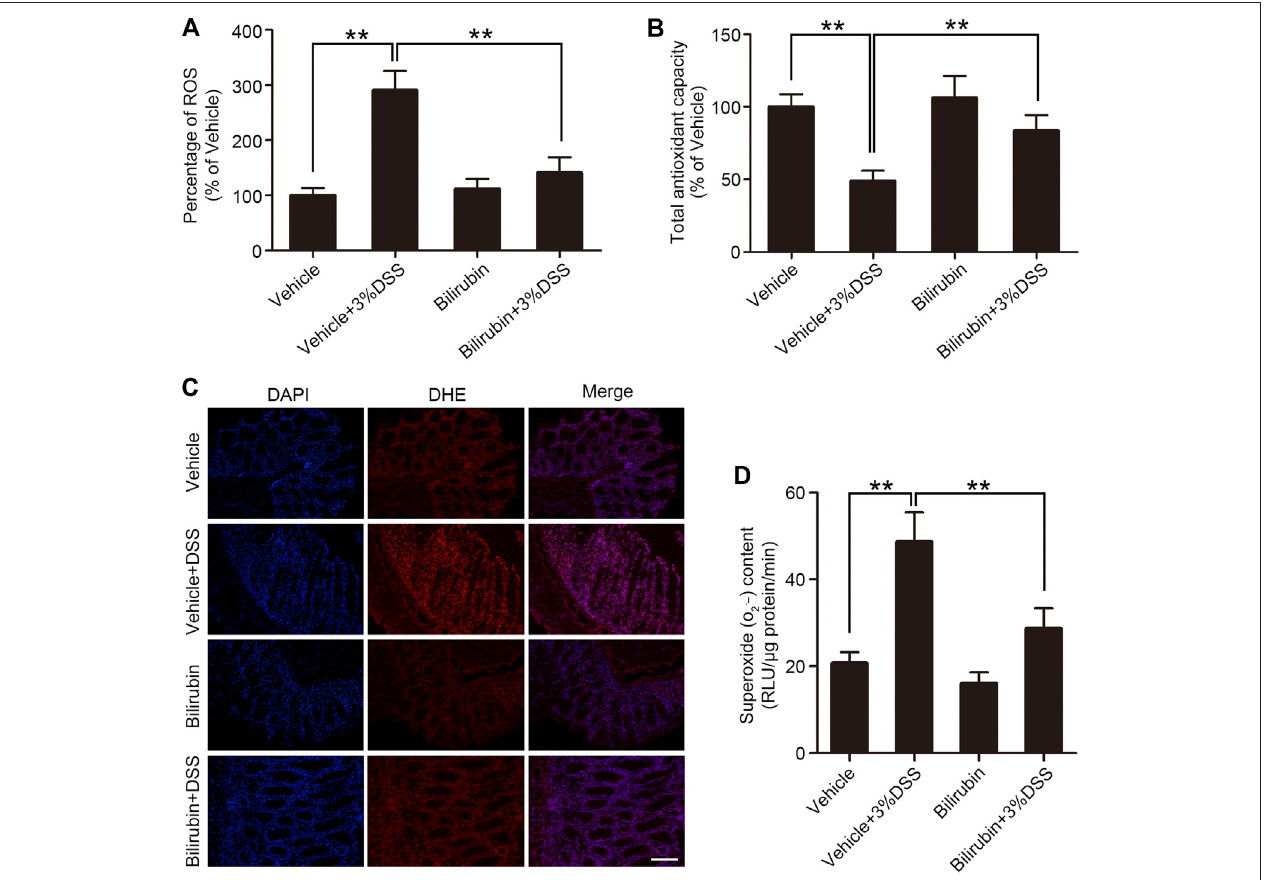
FIGURE 4 | UCB reduced colonic oxidative stress in mice with DSS-induced colitis. (A) Relative ROS levels (A) and (B) total antioxidant capacity (TAC) in the indicated groups. Data are expressed as percentage of controls (vehicle). Each bar represents the mean ± SEM ( n (cid:2) 6); * p < 0.05 and ** p < 0.01. (C) Representative imagesofDHE-stainedcolontissuesfromtheindicatedgroups.Bar (cid:2) 100 μ m. (D) Superoxideanion(O 2 ·− )levelsintheindicatedgroups.Dataareexpressedasmean ± SEM ( n (cid:2) 6). ** p <